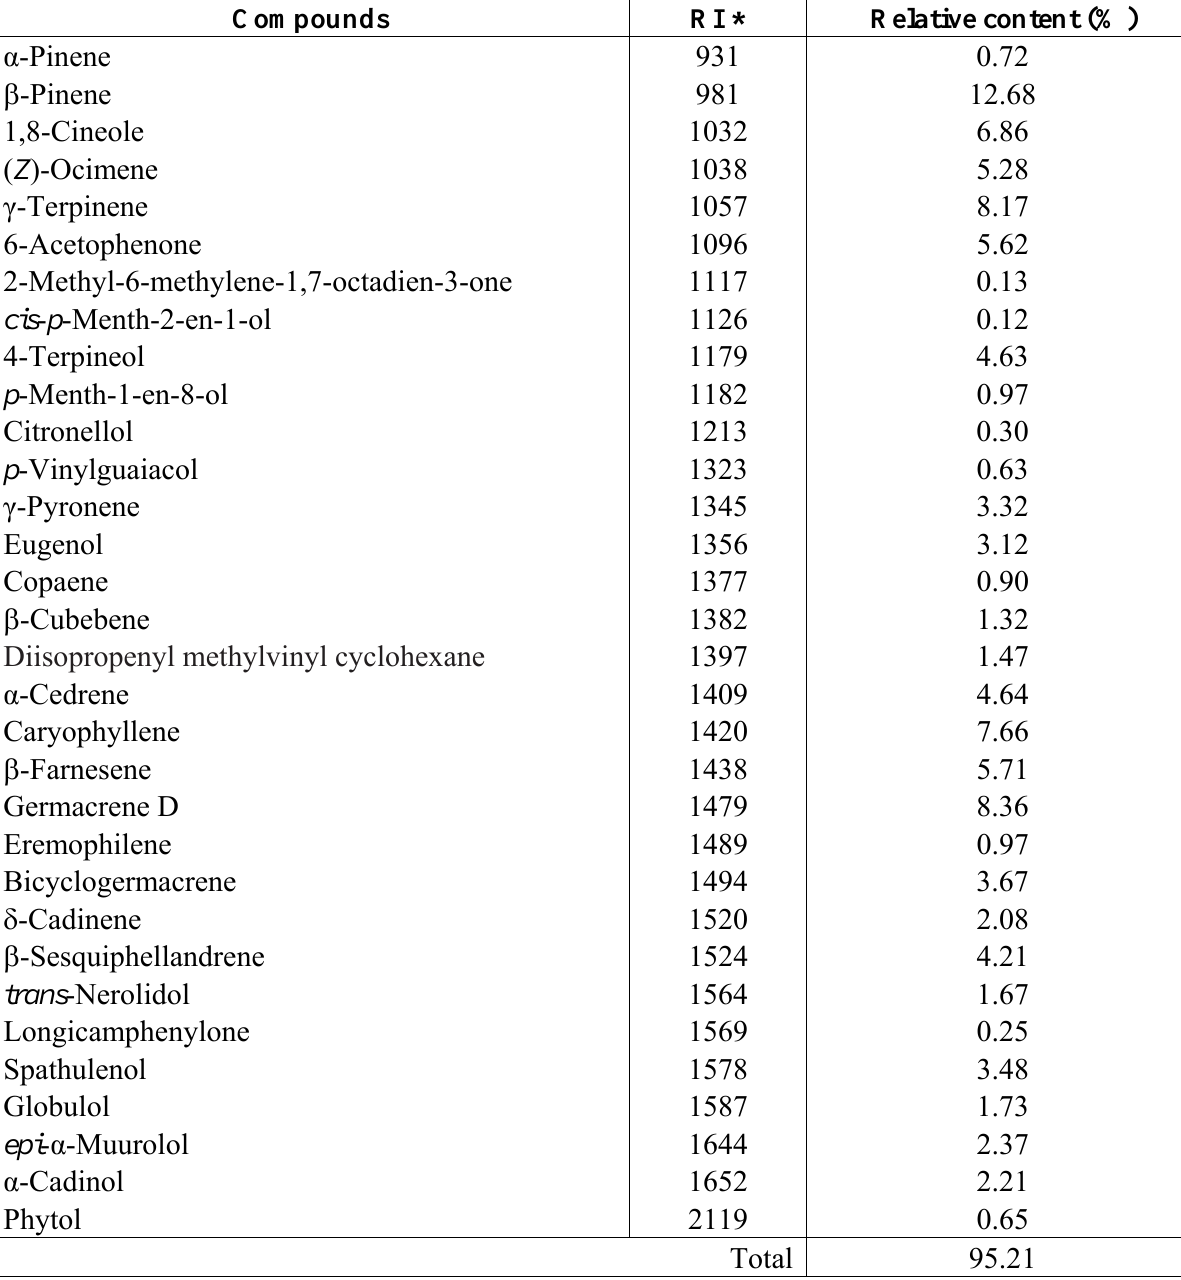
Table 2. Chemical composition of the essential oil of Artemisia capillaris